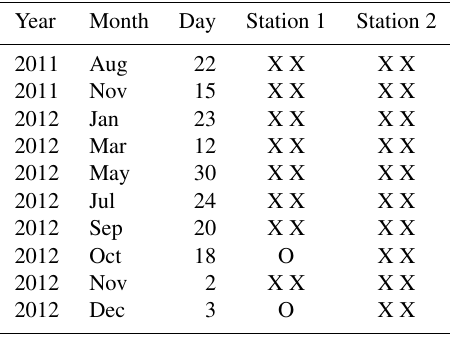
Table 1. Sampling dates of the samples which were investigated for living foraminifera for stations 1 and 2. X: one core investigated; O: no core